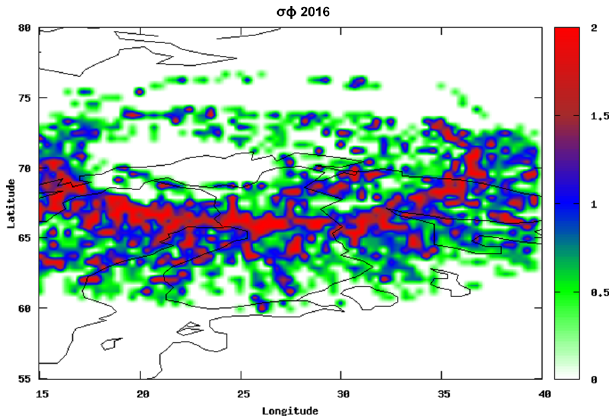
Figure 7. High-latitude phase scintillation cumulative map (phase index in radians).